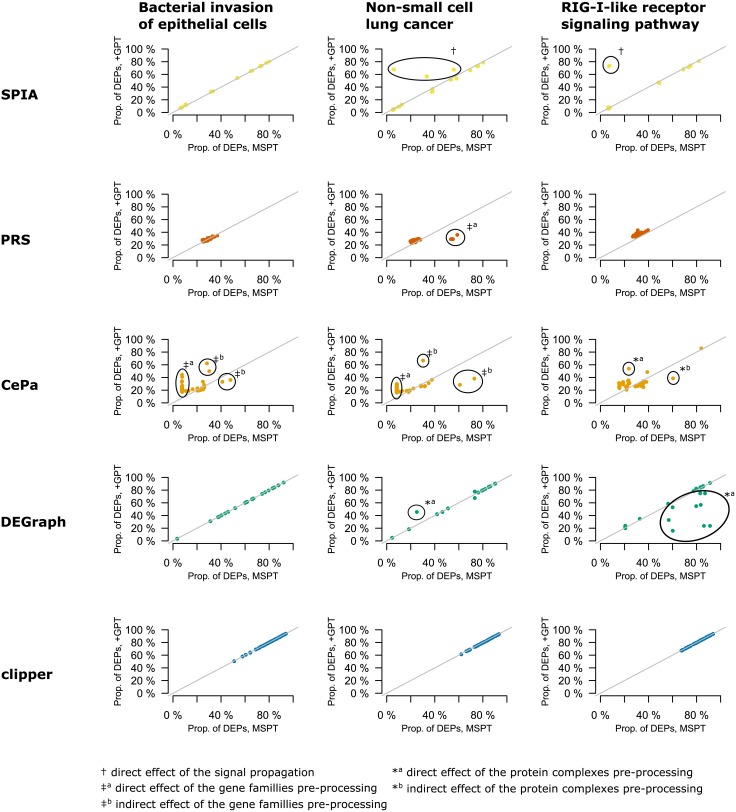
Effect of pre-processing of pathway topologies on simulated data—Overexpression of single gene.Each point represents a single gene. Only genes common for pathway topologies from graphite package (+GPT) and method-specific pathway topologies (MSPT) are displayed. Points on diagonal represent genes with the same influence in +GPT and MSPT. Points below (above) diagonal represent genes with higher (lower) influence in MSPT.